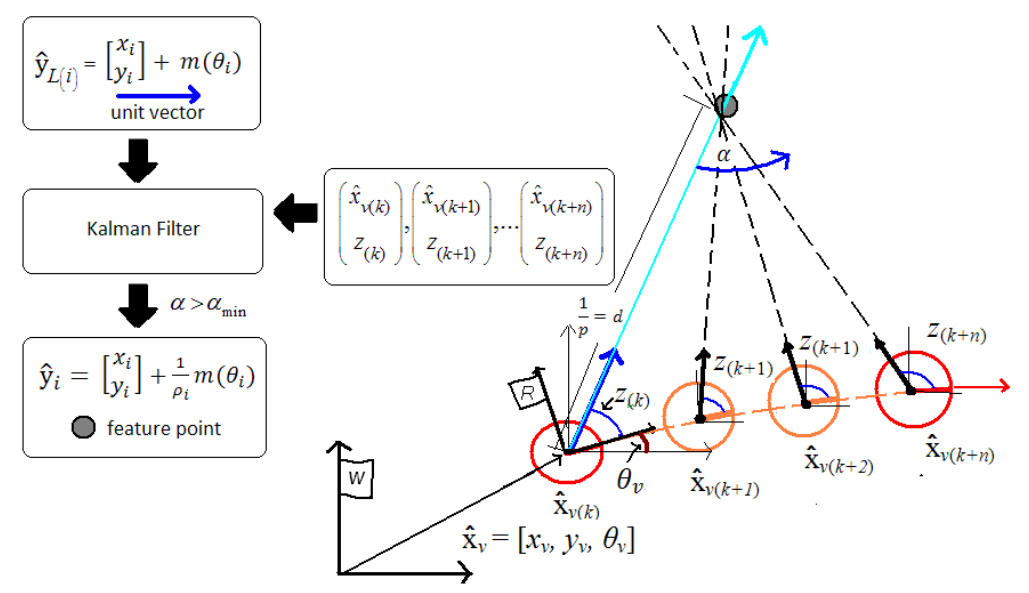
Figure 5. Concurrent initialization